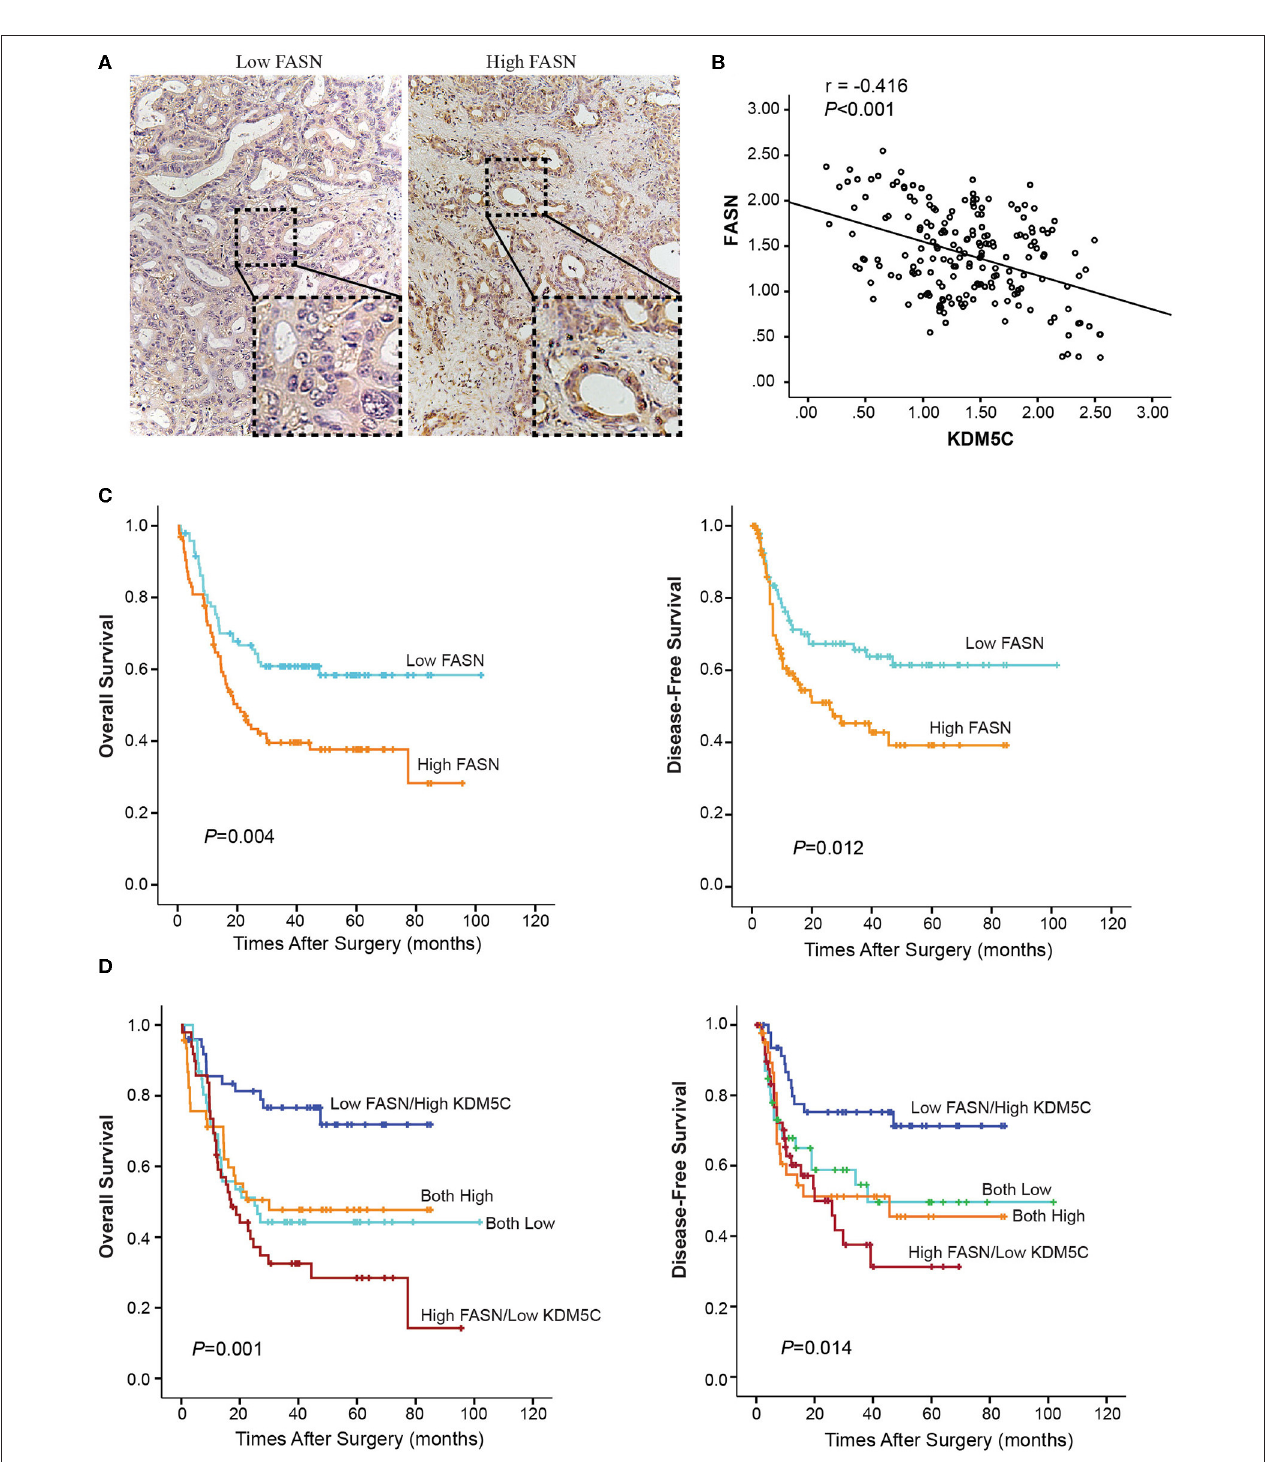
FIGURE 6 | Prognostic value of KDM5C and FASN for ICC patients. (A) Representative immunohistochemical images of high-FASN and low-FASN expression are shown. (B) Spearman’s correlation analysis showed that KDM5C expression level was negatively correlated with FASN expression level in ICC tissues ( p < 0.001, r = − 0.416). (C) The overall survival and disease-free survival of FASN-low and FASN-high patients were analyzed with Kaplan-Meier survival analysis. (D) The overall survival and disease-free survival of different groups according to the expression patterns of KDM5C and FASN were analyzed with Kaplan-Meier survival analysis. All results are from three independent